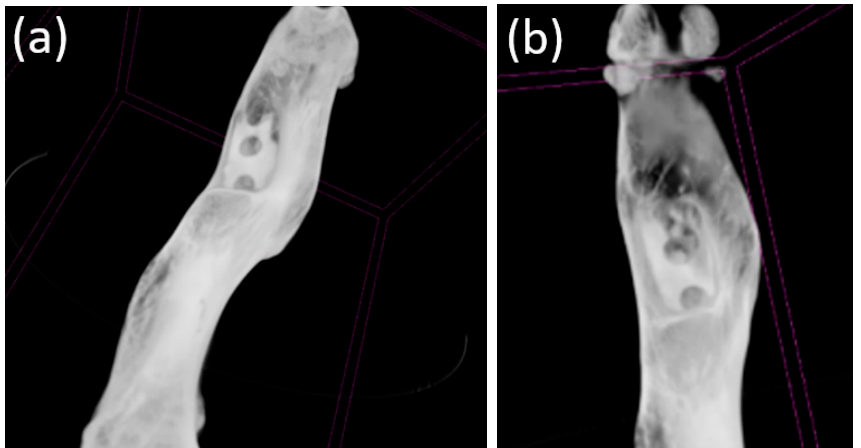
Figure 12. ( a,b ) Image of the femur of an animal 3 months after implantation (obtained using micro-CT). A decrease in the average density of the implants was visualized.